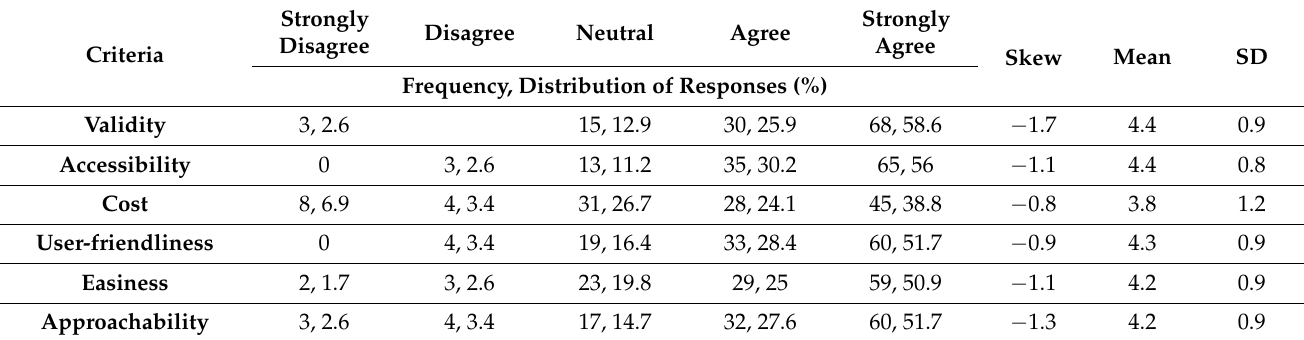
Table 5. Factors considered for choosing academic resources.